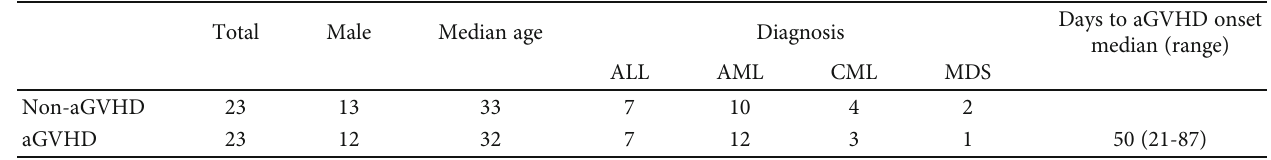
Table 1: Clinic characteristics of